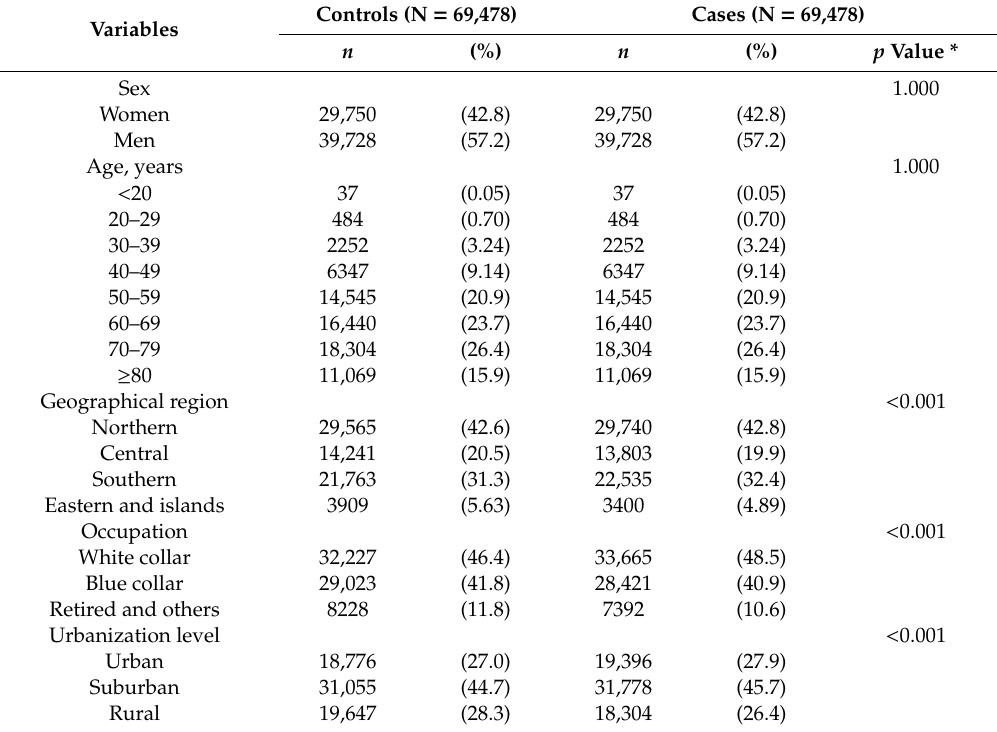
Table 1. Comparison of demographic characteristics and comorbidities between colorectal cancer patients and